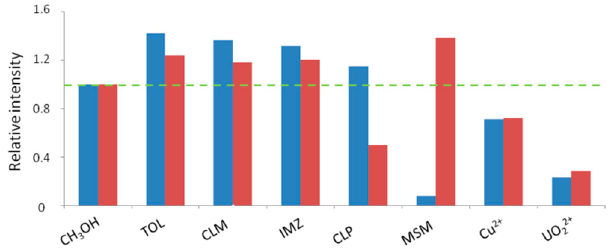
Figure 12. 5 D 0 → 7 F 2 intensities of X@Eu-BTC (blue) and X@Eu-BTC’ (red). The dashed green line denotes the systems without analyte presence.